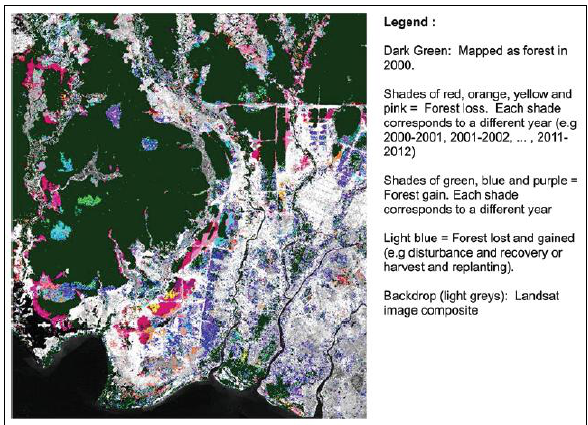
Figure 8. Year of first forest loss and gain at regional scale coloured by year of change as indicated in the legend above.